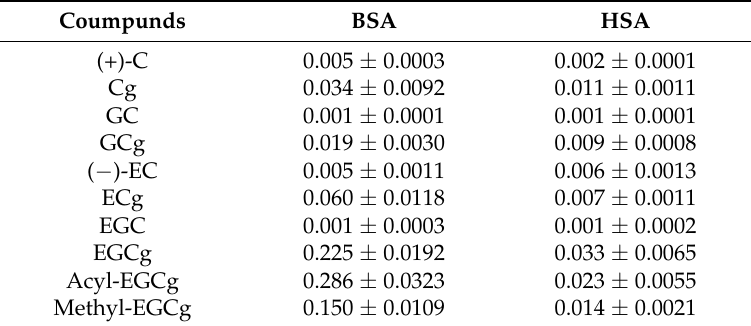
Table 1. Kq values of catechins against BSA and